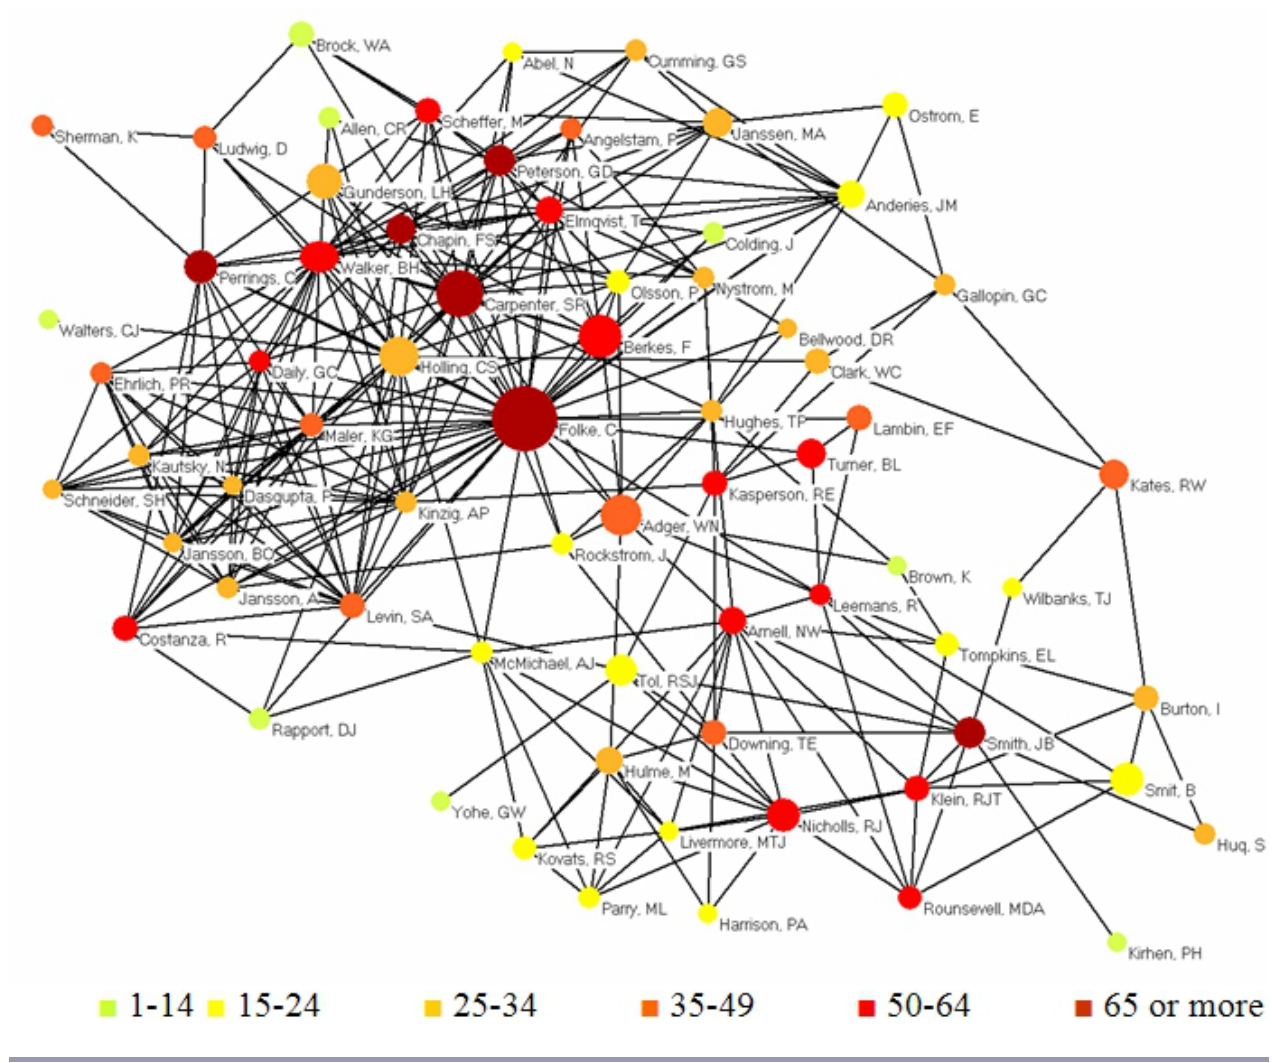
Fig. 2. Co-author network of the most productive and best connected authors with the strongest co- authorship relations. Circles denote author nodes, and are labeled by the author’s last name and initials. Legend: Node – author; Node area size—# of publications; Node area color—# of unique